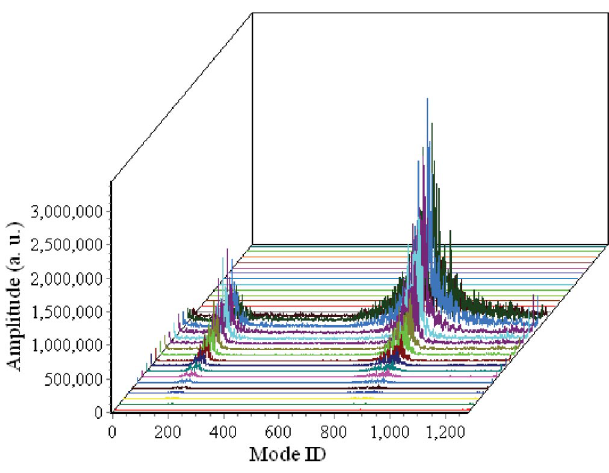
FIG. 5. (Color) Time evolution of horizontal unstable modes from mode 0 to